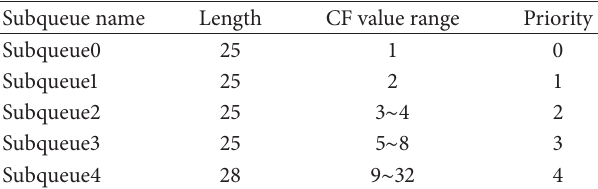
Table 2: Subqueues, CF, and priority correspondence.